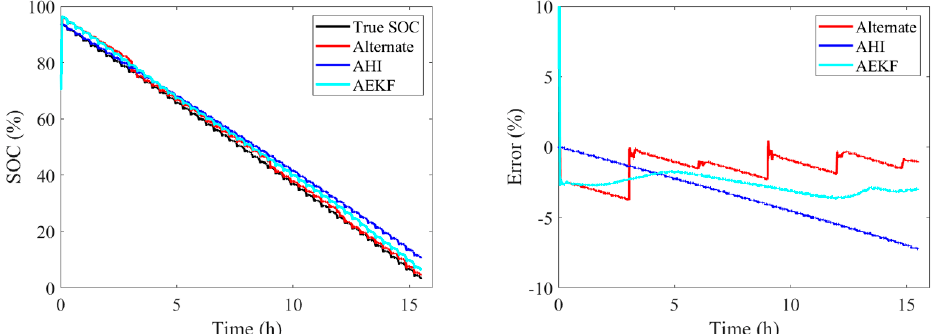
Table 3. Voltage and current drift errors.